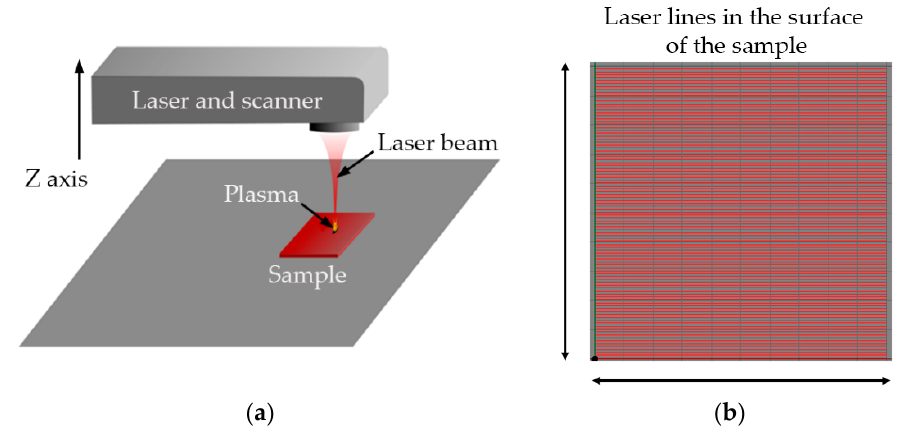
Figure 3. ( a ) Workstation; ( b ) scanner head motion schematic.